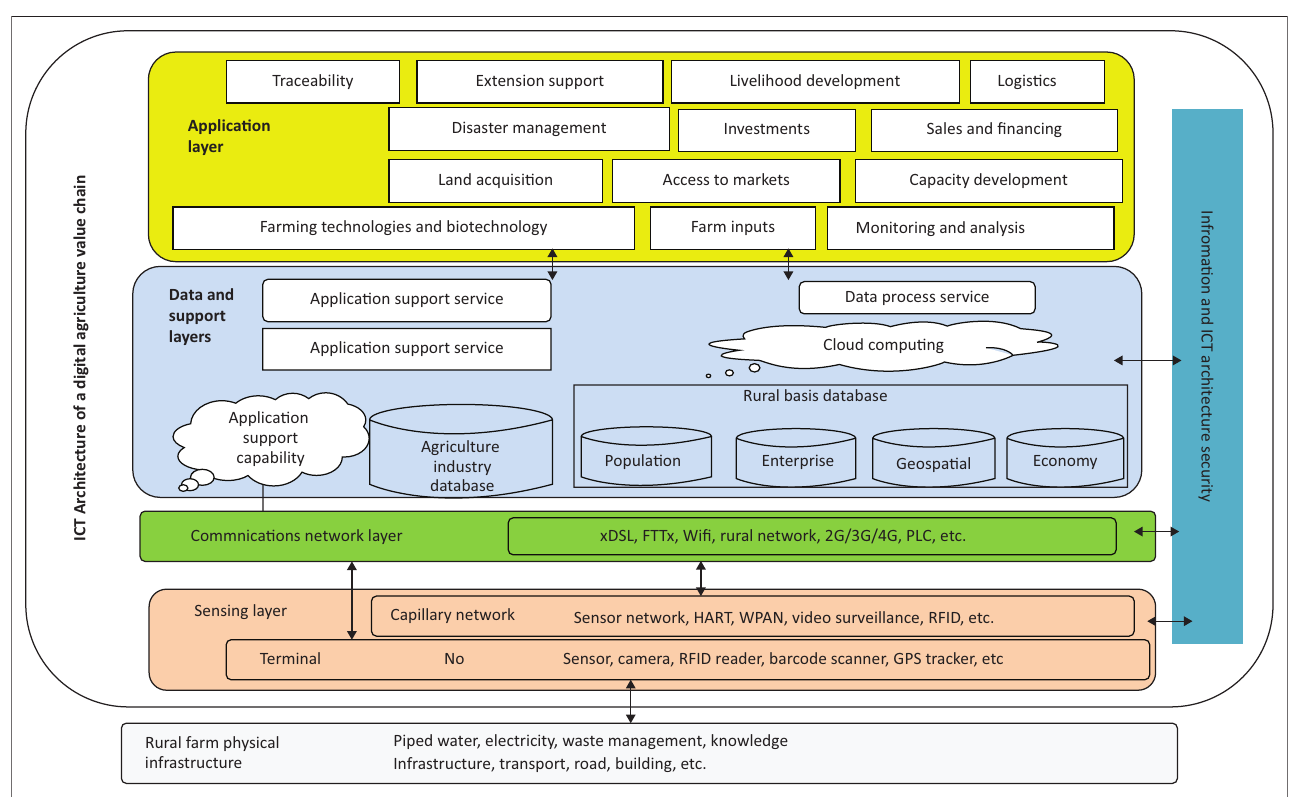
FIGURE 10: Agriculture sector cluster of digital services.